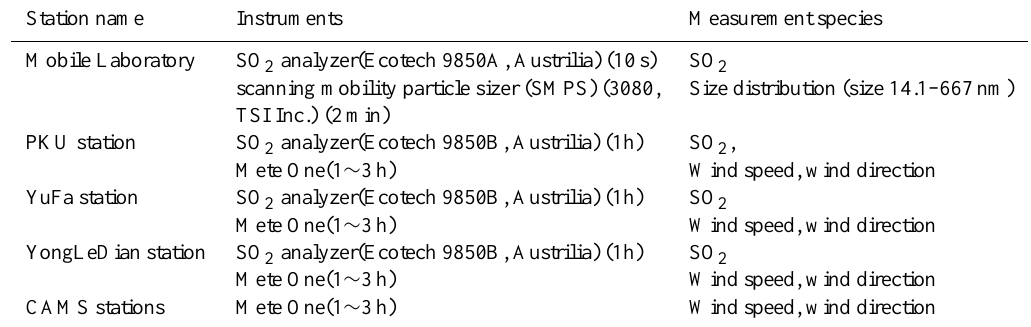
Table 2. Instrumentation performed in this